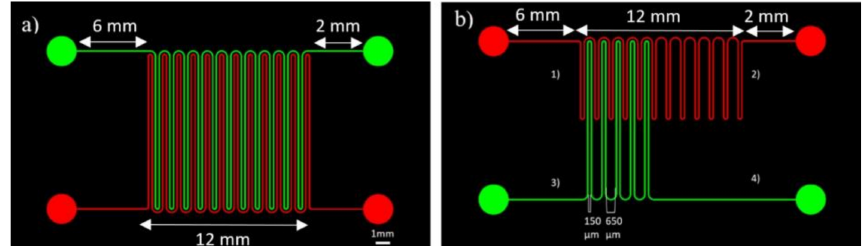
Figure 1. Microfluidic chip design. ( a ) The main chip type containing two separate, but interdigitated channels. The channels are 100 µ m wide and the gap between two channels is 150 µ m. The channel height is 40 µ m. ( b ) A chip variant used for mm scale patterning of four di ff erent microenvironments: (1) hypoxia and nitric oxide, (2) only hypoxia, (3) only nitric oxide, and (4) neither treatment. The channels have two gap dimensions, 150 µ m and 650 µ